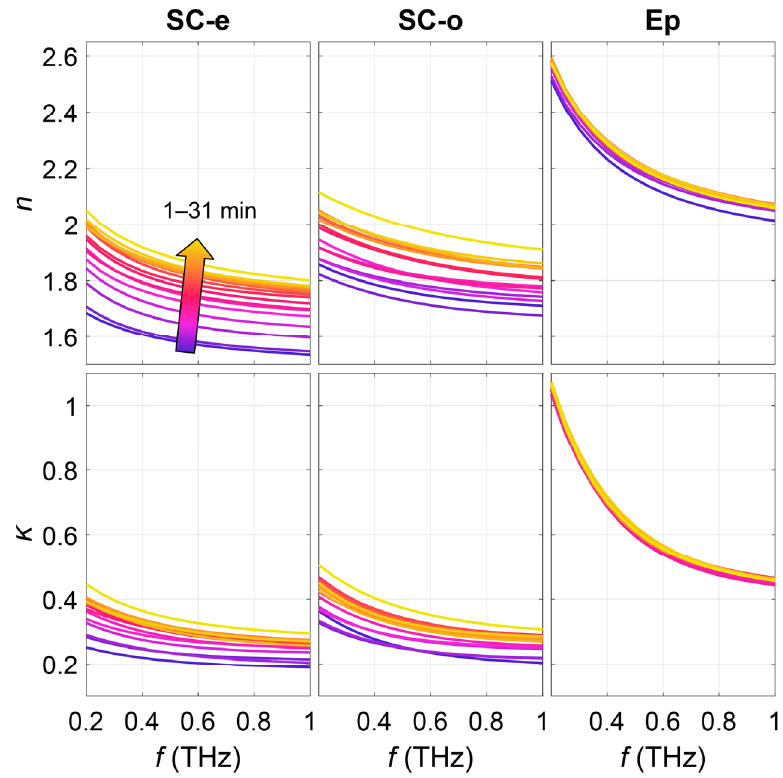
Figure 15. Refractive index and extinction coefficient spectra of the SC in the extraordinary and ordinary directions and epidermis during 30 min of occlusion [53]. ordinary directions and epidermis during 30 min of occlusion